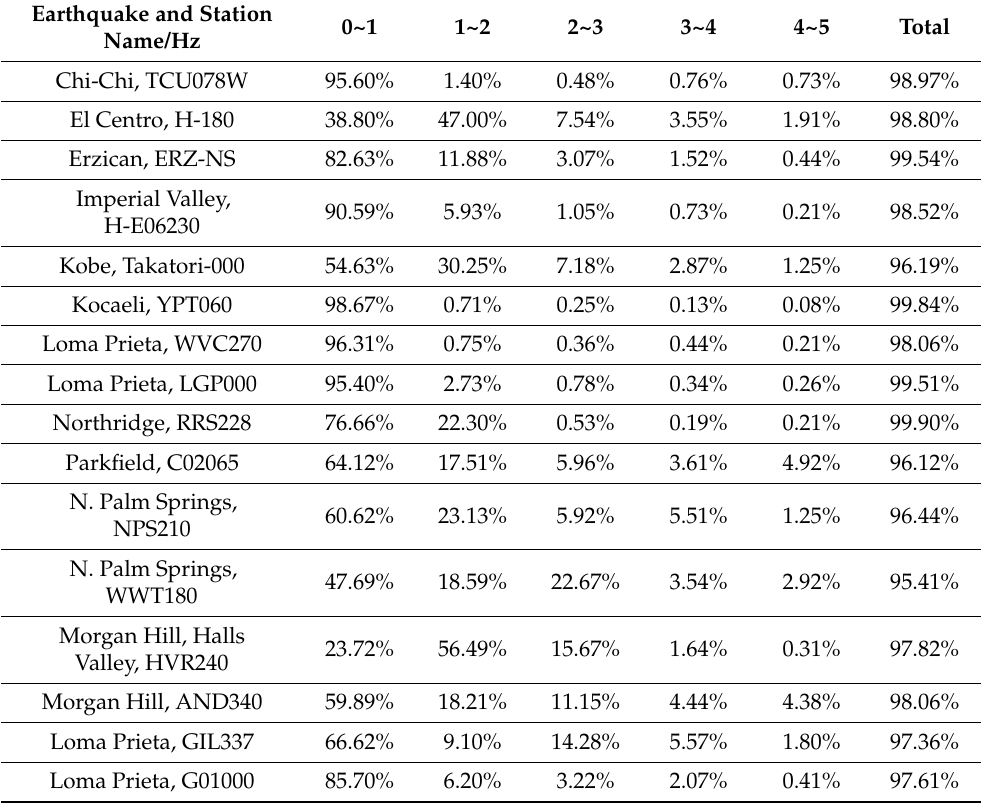
Table 1. Energy distribution of near-fault